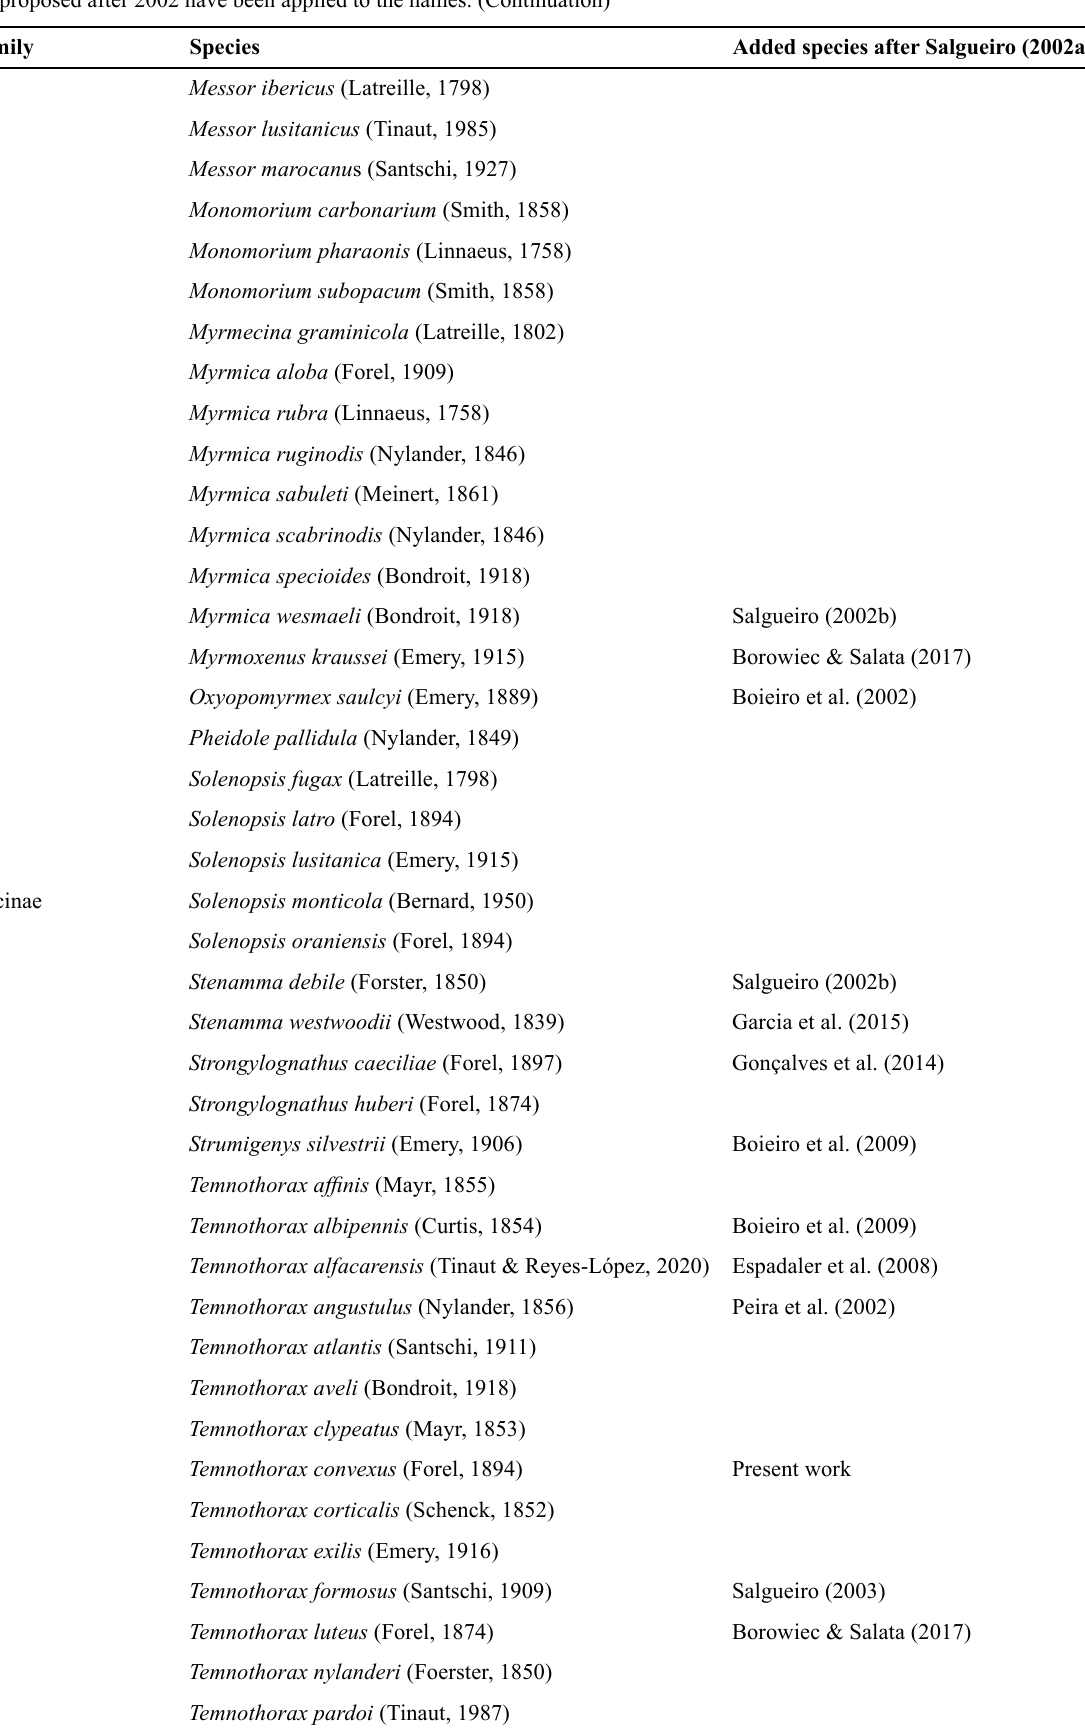
Table 3 . Complete checklist of continental Portuguese ant fauna, combining that of Salgueiro (2002a) and posterior additions. Nomenclatural changes proposed after 2002 have been applied to the names. (Continuation) Subfamily Species Added species after Salgueiro